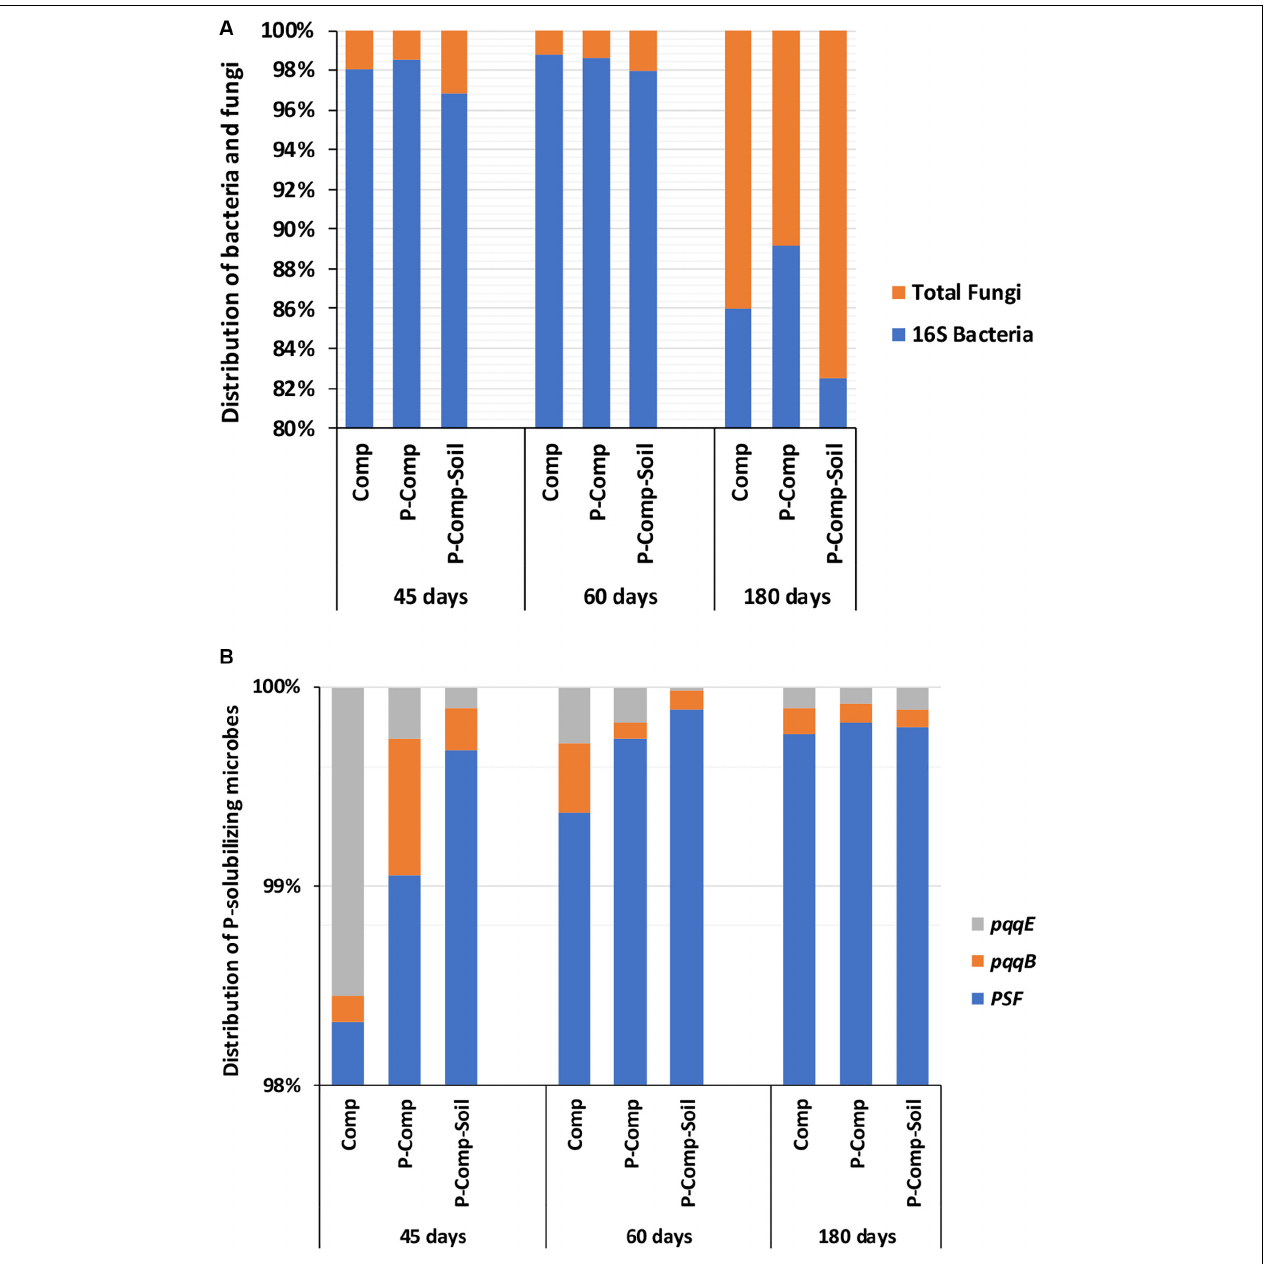
FIGURE 2 | Distribution of bacteria and fungi (A) , and P-solubilizing microbes in composts (B) . Sampling was carried out at 45, 60, and 180 days. The data of each treatment at a given sampling period are averages of 3 replications per treatment. Comp, sole compost with sorghum straw as organic material; P-Comp, Burkina phosphate rock (BPR)-enriched compost; P-Comp-Soil, BPR-enriched composted with addition of rhizosphere soi; PSF, P-solubilizing fungi; pqq, pyrroloquinoline